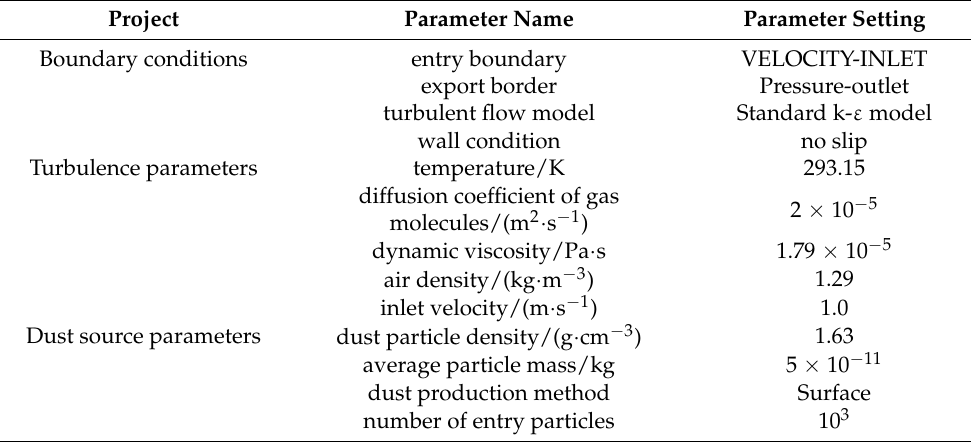
Table 1. Boundary conditions and parameter